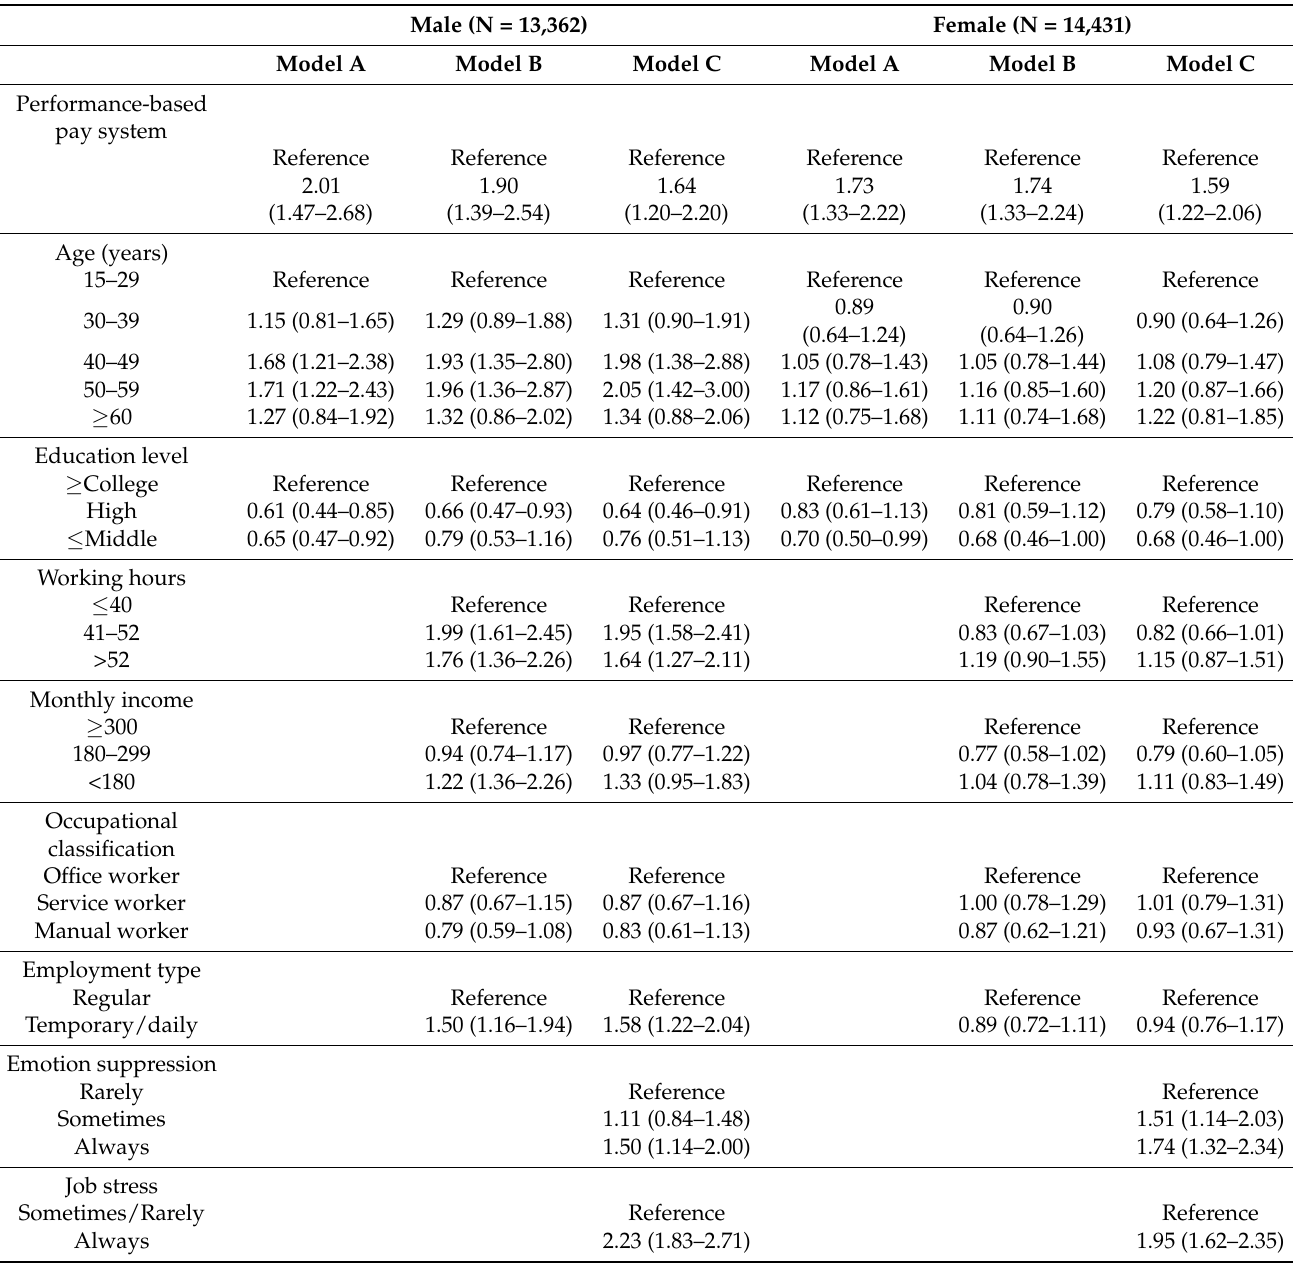
Table 3. The association between performance-based pay system and reporting symptoms of depres- sion/anxiety by the logistic regression